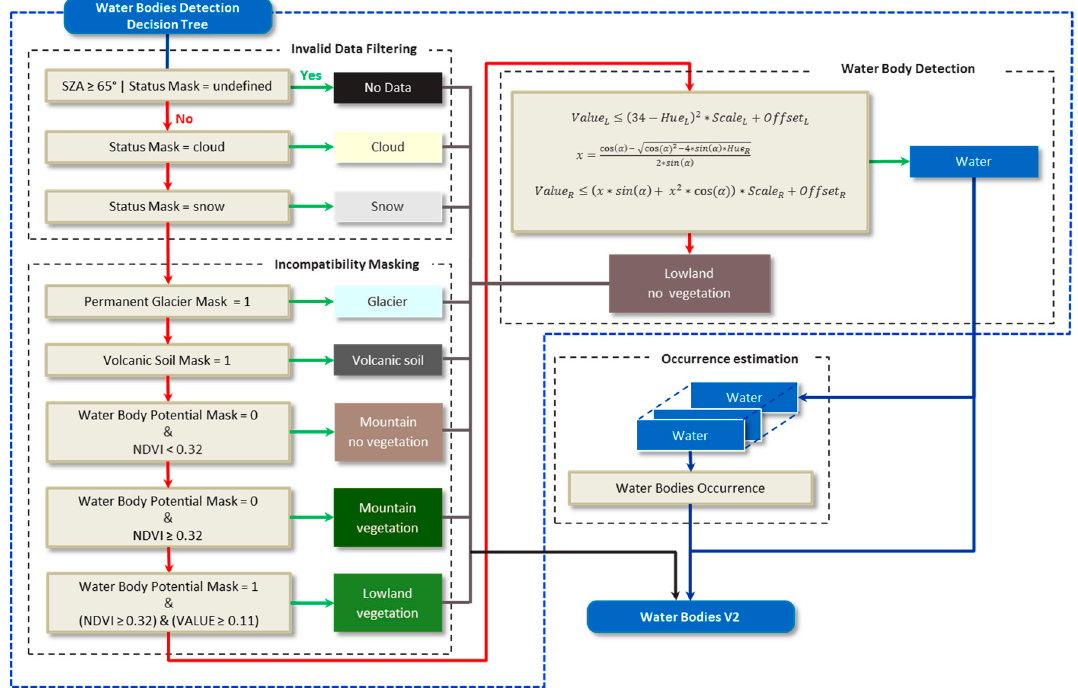
Figure 5. The Water Body Detection Algorithm consists of three main steps: (i) invalid data filtering; (ii) incompatibility masking; and (iii) water body detection. Qualitative information about the detected water bodies is expressed by the occurrence estimation. Both layers, i.e., the detected water bodies and the occurrences, are available in the Water Bodies V2 product.